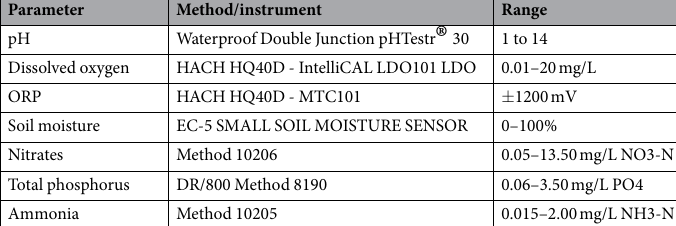
Table 1. Column study sample quality parameters and